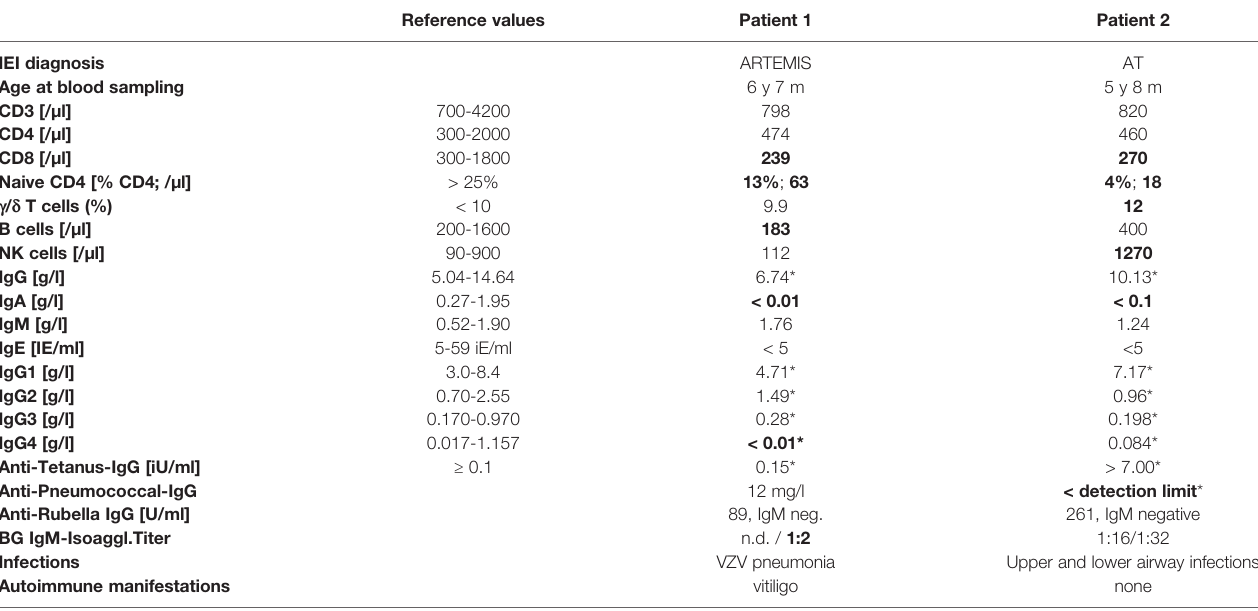
TABLE 1 | Clinical, genetic and immunological characteristics of patient 1 and